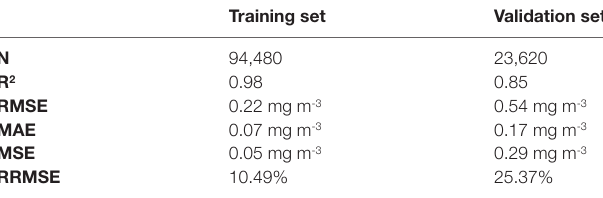
TABLE 2 | Evaluation of RF model performance.